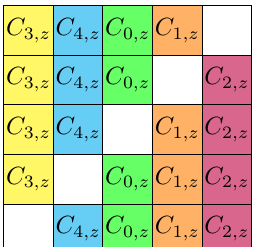
Figure 4: The difference between two inner colliding states after χ when the inner state is one plane. We call the constant for each column C x,z , 0 ≤ x < 5, 0 ≤ z < ω . The anti-diagonal can be set to any